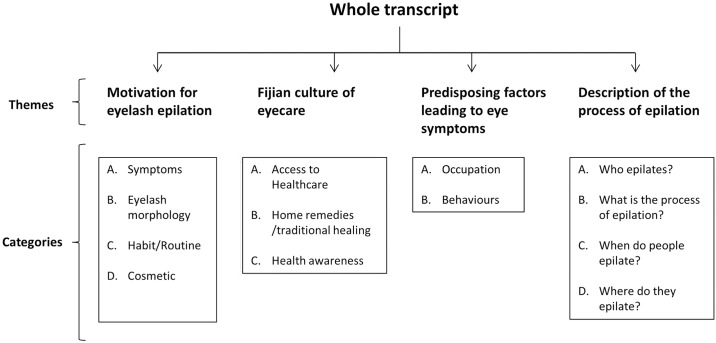
Categories and themes derived from the transcript of the focus group of epilating individuals, Western Division, Fiji, 2013.